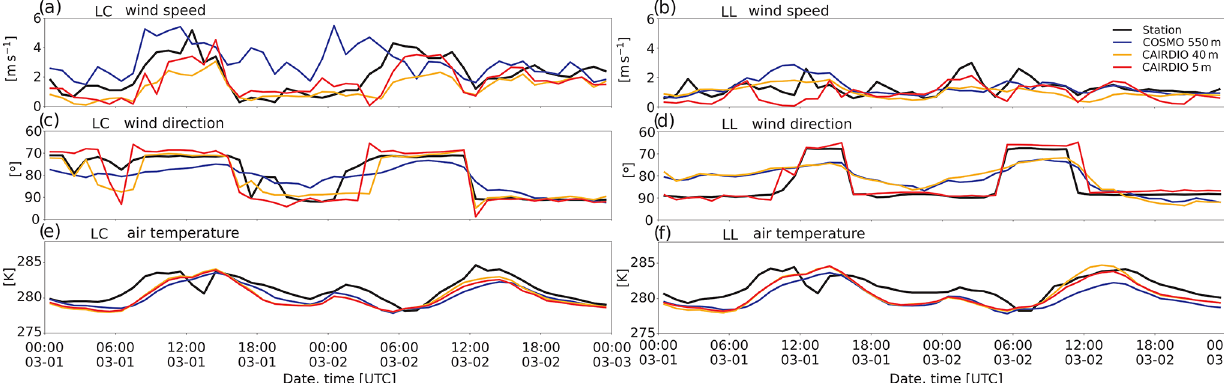
Figure B1. Model comparison of hourly-averaged near-surface observations (black lines) wind speed, wind direction, and air temperature with observations at the air monitoring sites LL (a, c, e) and LC (b, d, f) . In the comparison included are the simulations COSMO M3 (blue lines), CAIRDIO L0 40m (orange lines) and CAIRDIO LL, respective LC, with 5m grid spacing (red